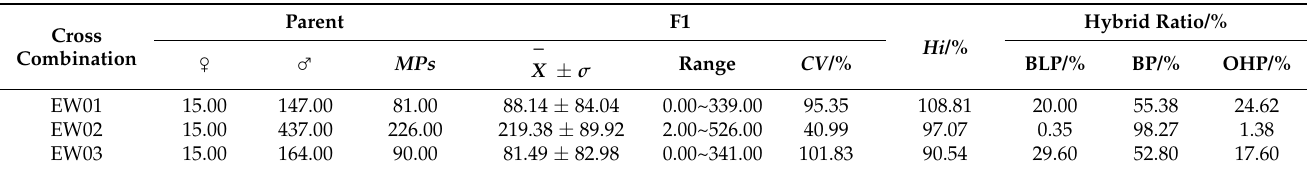
Table 4. Heterosis analysis of spots number in three cross